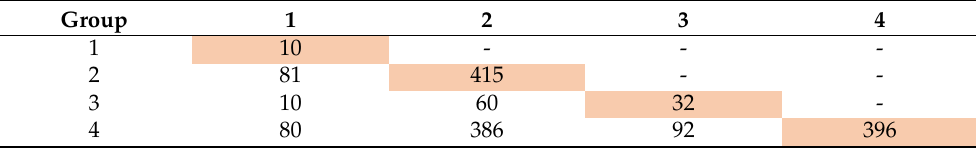
Table 1. Gene connectivity based on protein–protein interactions computed by STRING. The orange- filled cells represent intragroup interactions, shown in Figures 1–3 as edges. Group 1 2